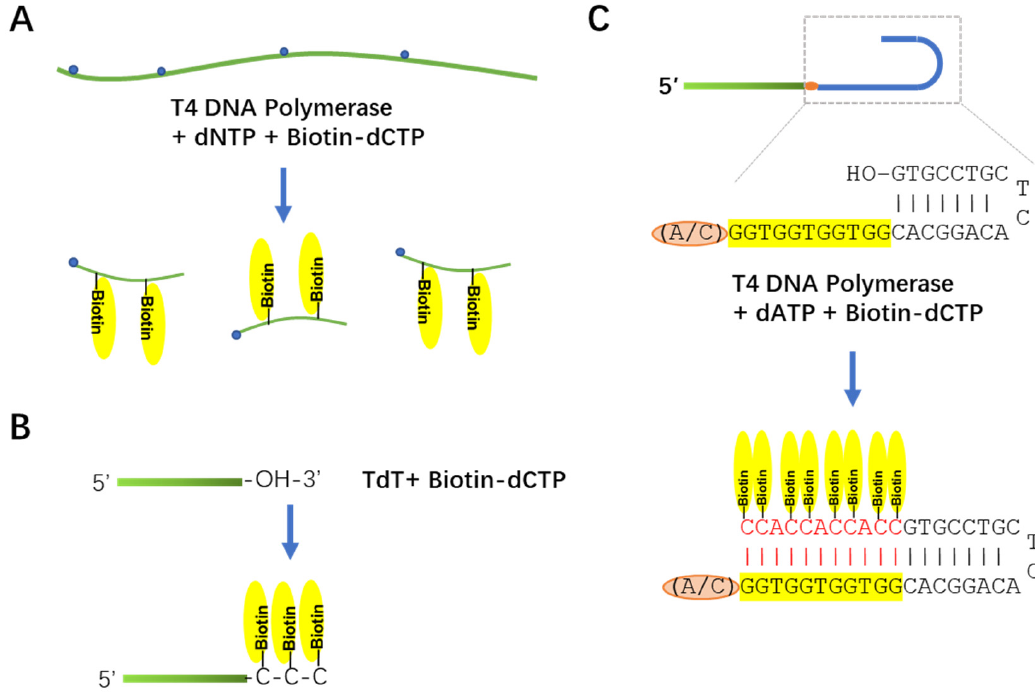
Figure 1. Mechanism of probe labeling. ( A ) Mechanism of random priming labeling. Green flexible line represents double-stranded DNA template while the shorter and thinner green line represents single-stranded DNA probe synthesized in labeling reaction. Blue dots represent random hexamer primers. Yellow ovals represent biotin module attached to cytosine. ( B ) Labeling of short DNA oligo using terminal nucleotide transferase. Green bars represent probe sequences. TdT, terminal deoxynucleotidyl transferase. ( C ) Short hairpin enabled T4 DNA polymerase-mediated labeling method. Green bar, probe sequences; brown oval, insolating nucleotide (A/C); blue “U” shape line, hairpin